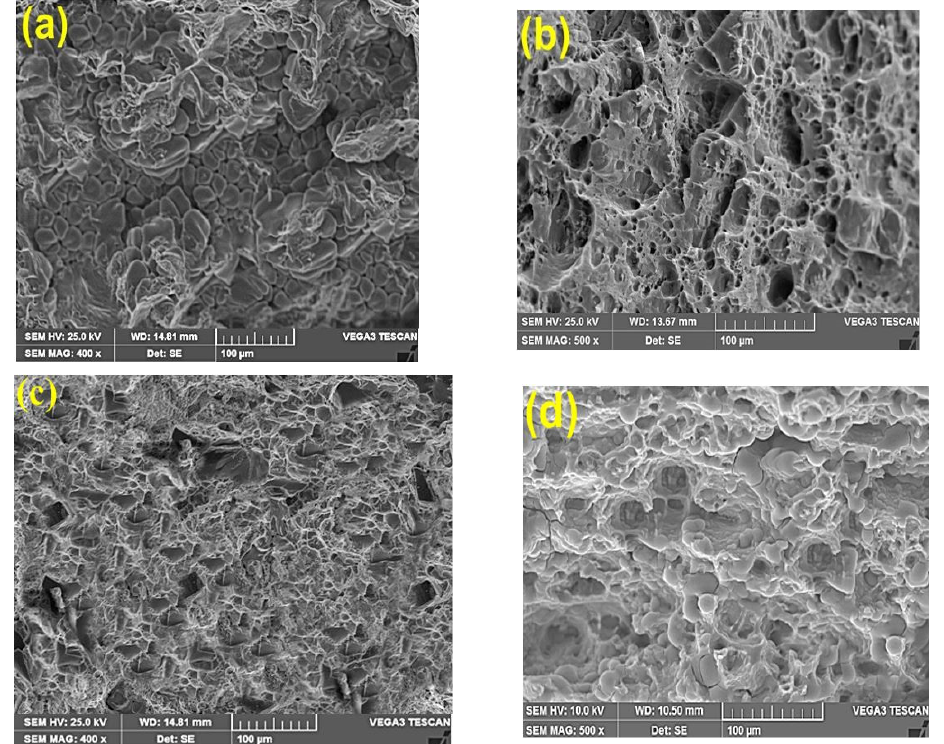
Figure 6. ( a – d ) ( a ) Fracto-graphic image of as-cast Al2014 before heat treatment, ( b ) Fracto-graphic image of as-cast Al2014 alloy after T6 heat treatment, ( c ) Al2014-15 wt.%, Al 2 O 3 composite before heat treatment and ( d ) after heat treatment condition, respectively.